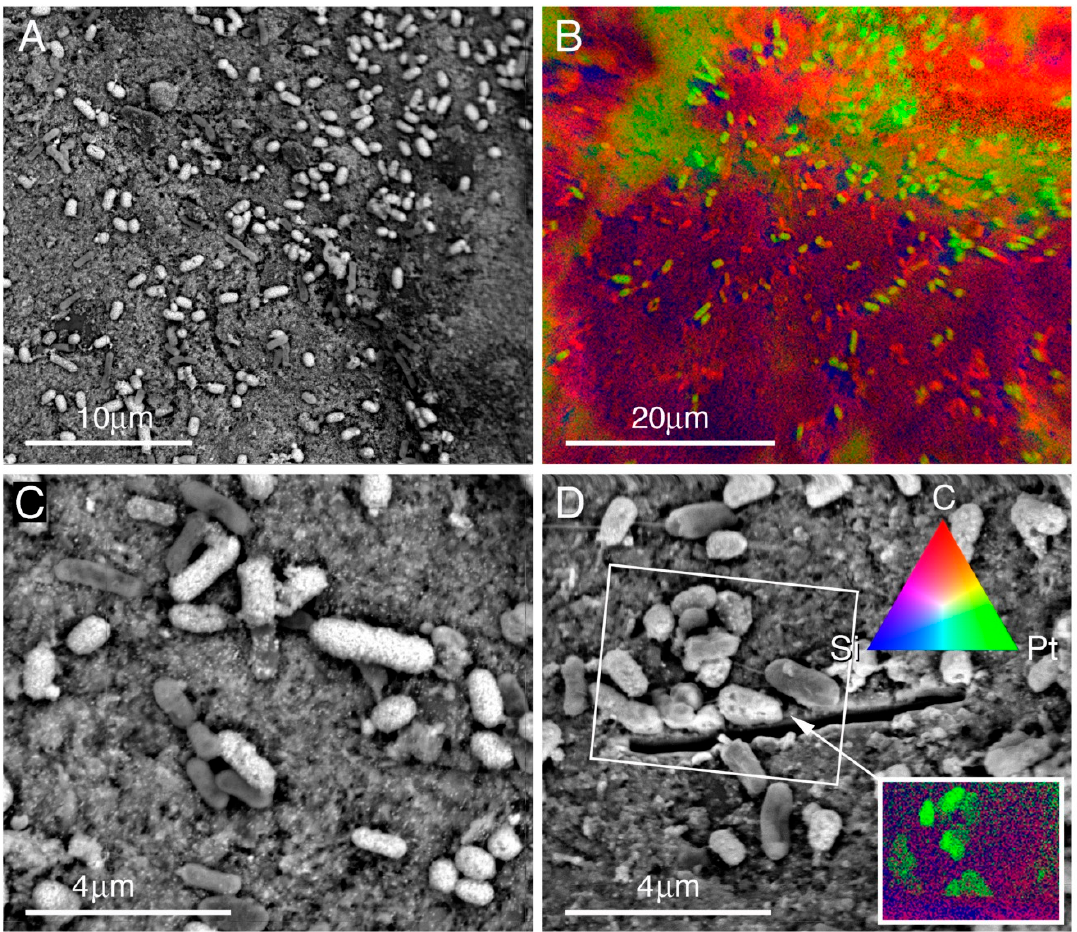
Figure 2. SEM micrographs of the E. coli biofilm from column experiments showing overall morphology ( A ); energy-dispersive X-ray analysis (EDXA) element map (C, Pt, Si) showing the distribution of platinum in the biofilm ( B ); detailed view of individual active cells and conglomerates of platinum replacing bacteria cells in the biofilm ( C , D ), with EDXA map (C, Pt, Si) of replaced cells ( D ). A FIB cut in ( D ) exposes the porous nature of the secondary platinum.